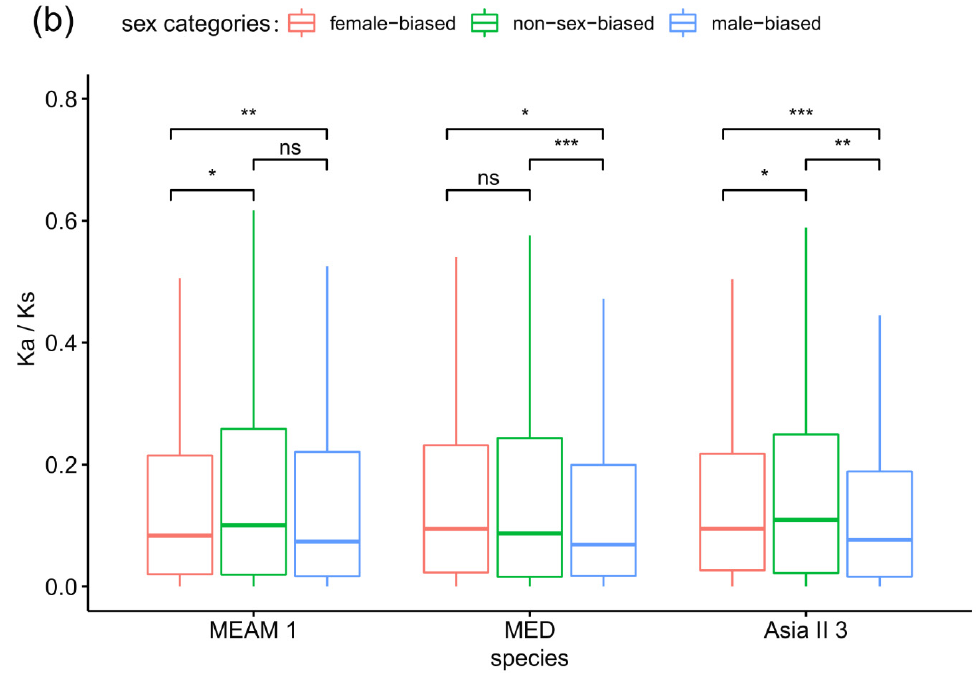
Figure 2. The number of orthologous genes that exhibit sex-biased or non-sex-biased expression and the evolution of their protein coding sequences. The number of orthologous genes ( a ) and average rate ratio of synonymous to non-synonymous substitutions (Ka / Ks) ratios for orthologous genes ( b ). Significant differences were determined by the Mann–Whitney U tests for pairwise comparisons: ns p > 0.05, * p < 0.05, ** p < 0.01, *** p < 0.001.